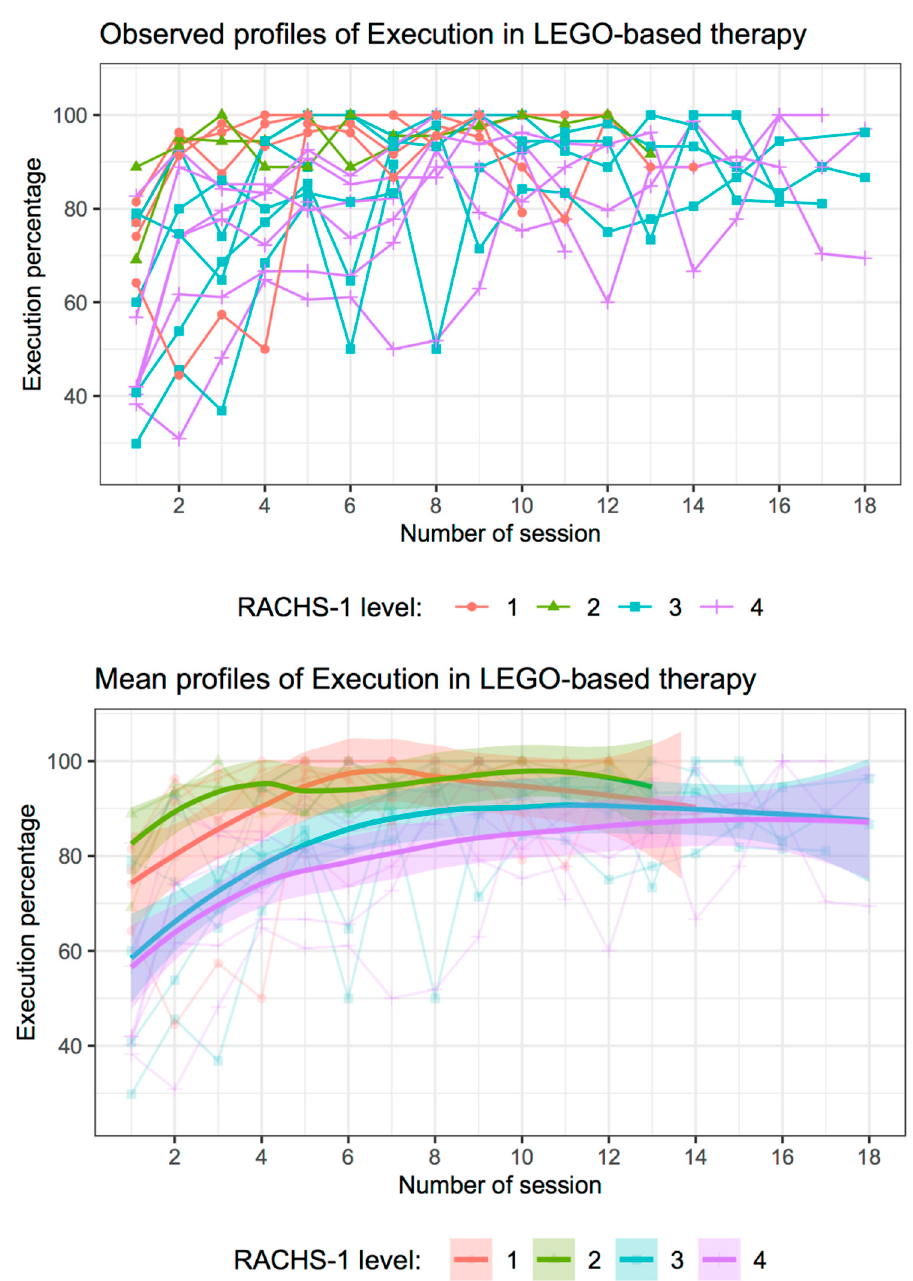
Figure 1. Evaluation of execution of pediatric patients with congenital heart disease in LEGO ® -based therapy by sessions and RACHS-1 classification. ( Top ): Observed profiles of each patient colored by his/her RACHS-1 level. ( Bottom ): Mean of profiles computed with the loess smoothing method (solid line) and 95% confidence intervals (shaded areas); colored lines represent the RACHS-1 level.